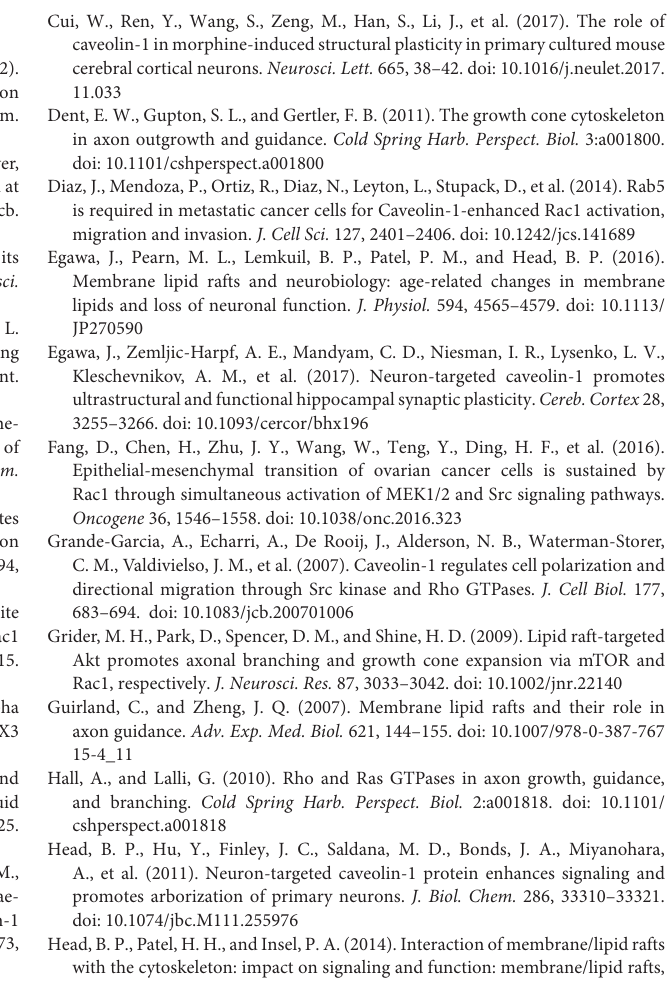
FIGURE S1 | Representative tracing images using Autoneuron, which measures 3D image volume stacks (MBF Bioscience) generated by Neurolucida as previously described (Head et al., 2011). FIGURE S2 | Time course of SynCav1 -mediated increase in total Cav-1 protein expression at 24, 48, and 72 h. Upper band, GAPDH; lower band, Cav-1. SC represents SynCav1